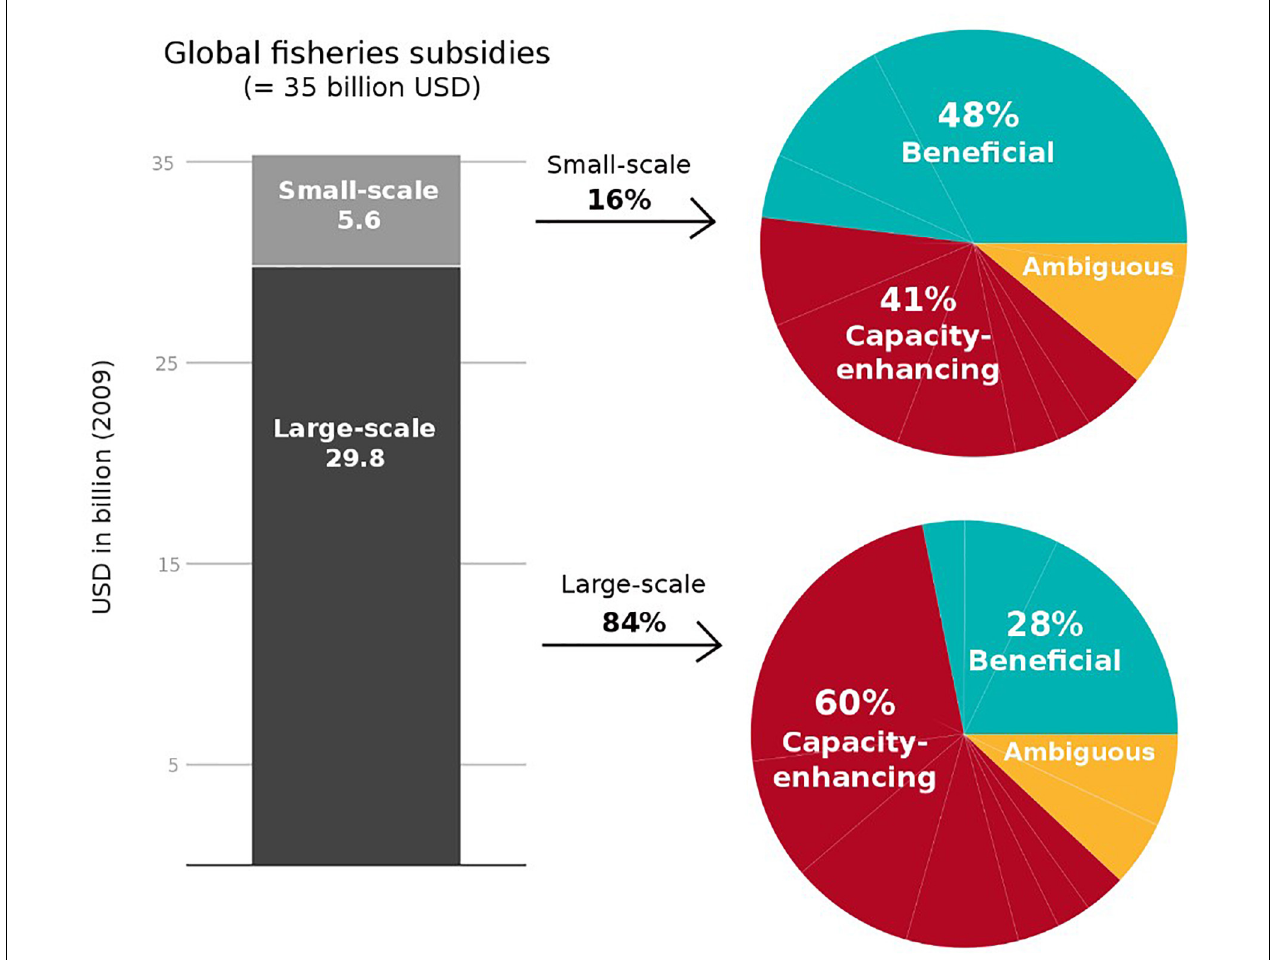
FIGURE 4 | Subsidies that stimulate overcapacity in large-scale industrial fisheries can lead to overfishing. Figure adopted from Schuhbauer et al. (2017).